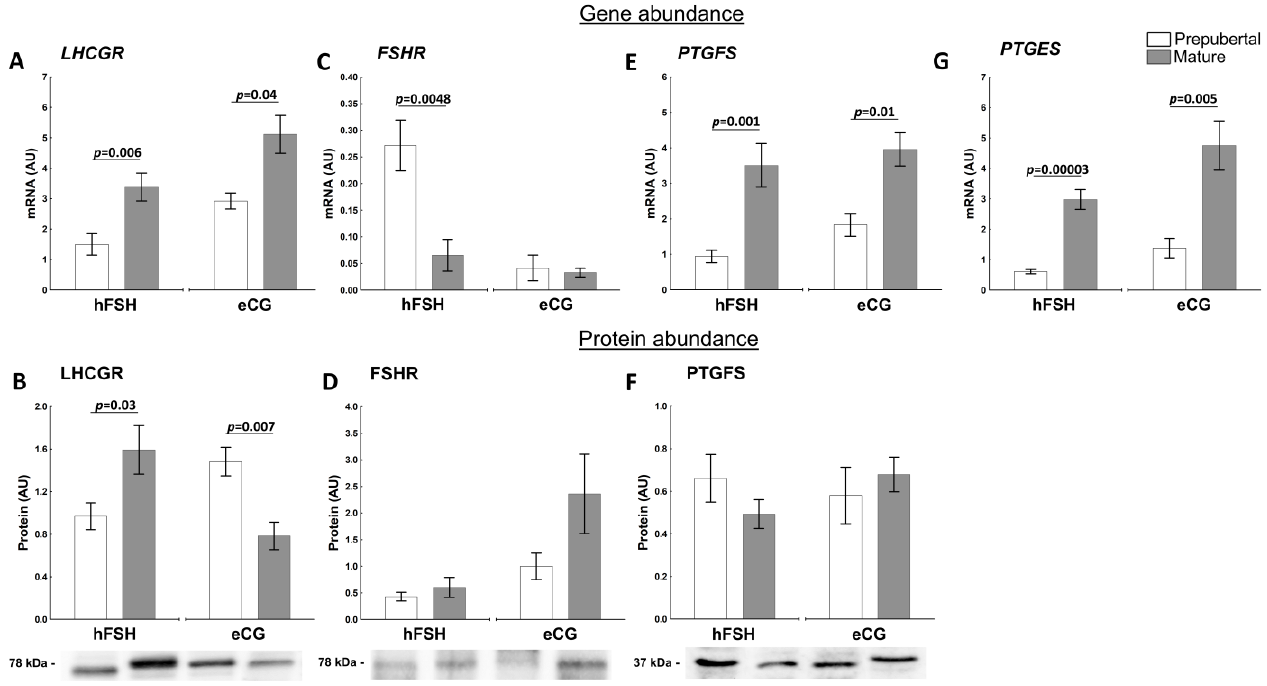
Figure 4. Sexual maturity status (pre-puberty or maturity) affect abundance of factors related tosteroid hormone synthesis and gamete production in ovarian follicles of hFSH- and eCG-primed gilts. The abundance of LHCGR ( A , B ), FSHR ( C , D ), PTGFS ( E , F ) and PTGES ( G ) in prepubertal and mature gilts was evaluated. Gene expression was normalized to the geometric mean of ACTB and GAPDH , identified as the best reference genes by NormFinder algorithm. Protein levels were normalized to total protein content using TGX Stain-Free gel technology ( B , D , F ). Uncropped blots are presented in Supplementary Figure S 2. Data were analyzed using Student’s t -test for each treatment and are presented as mean ± SEM (n = 6 per group). Line with a p -value denotes significant differences between prepubertal and mature gilts. AU — arbitrary units.